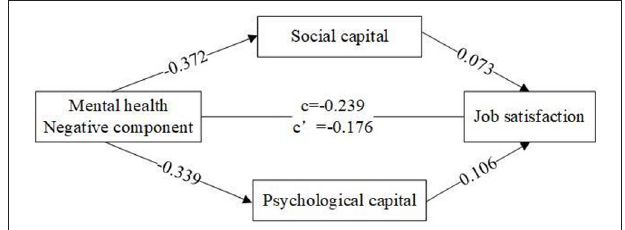
FIGURE 3 | The mediating role of psychological and social capital between the negative component of mental health and job satisfaction.